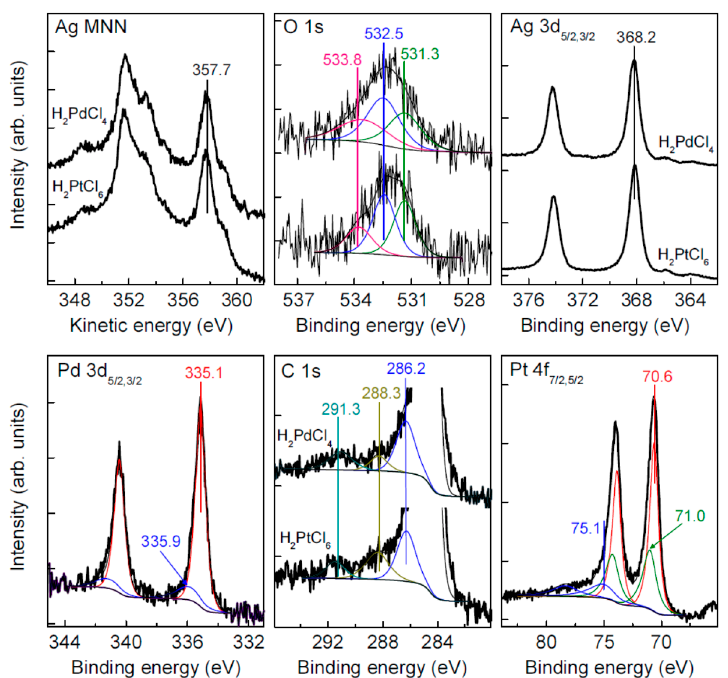
Figure 8. XPS spectra of silver films conditioned in H 2 PtCl 6 solution for 20 min, and in H 2 PdCl 4 solution for 40 min.